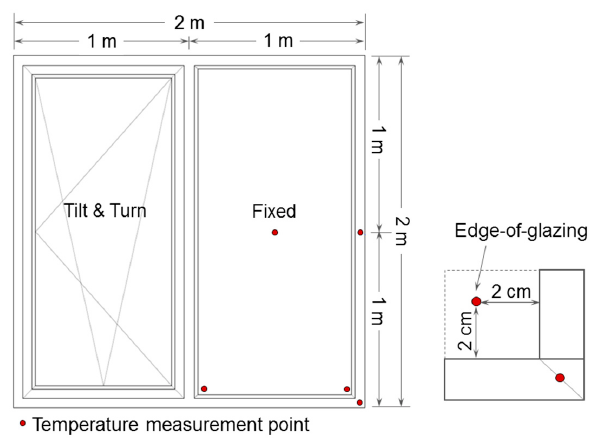
Figure 2. The tested window scheme and assessment points.